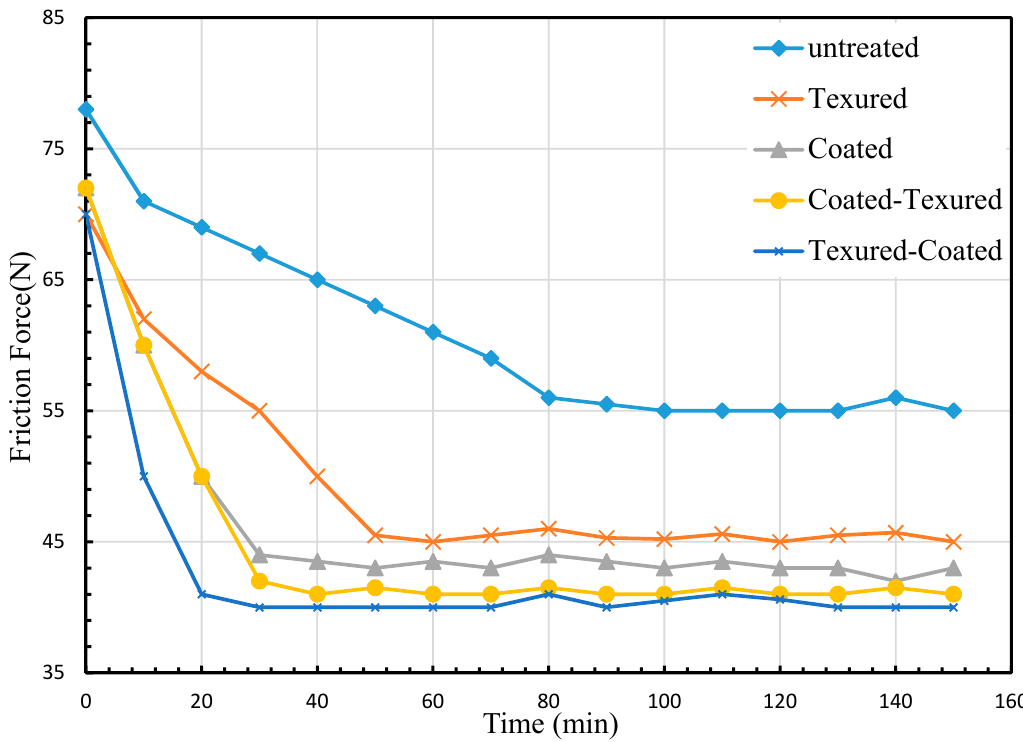
Figure 7. Running-in behavior of textured, coated, coated-textured, and textured-coated piston rings.